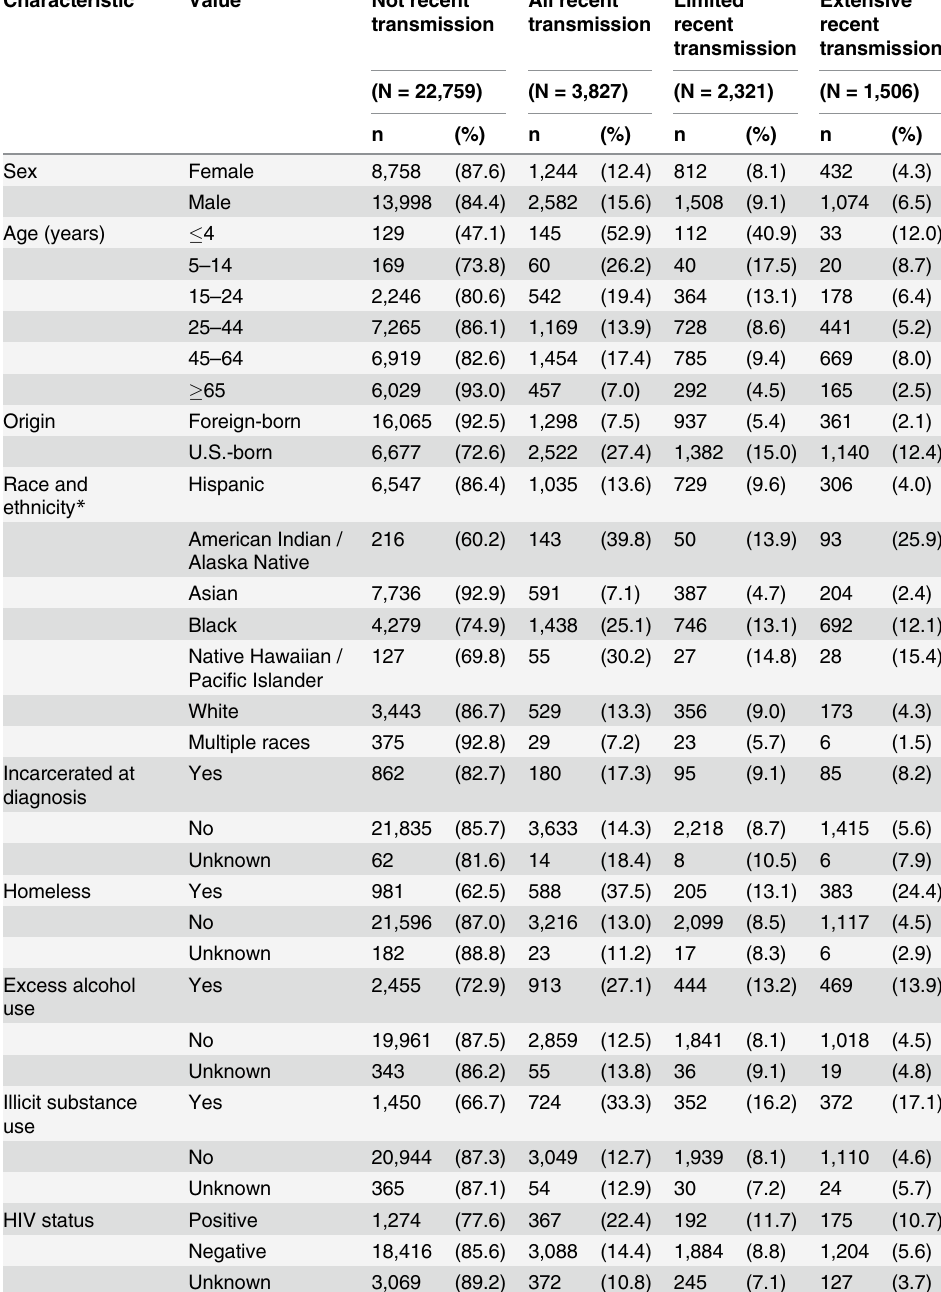
Table 1. Frequency of patient characteristics among cases not attributed to recent transmission (N = 22,759) and attributed to recent transmission (N = 3,827).